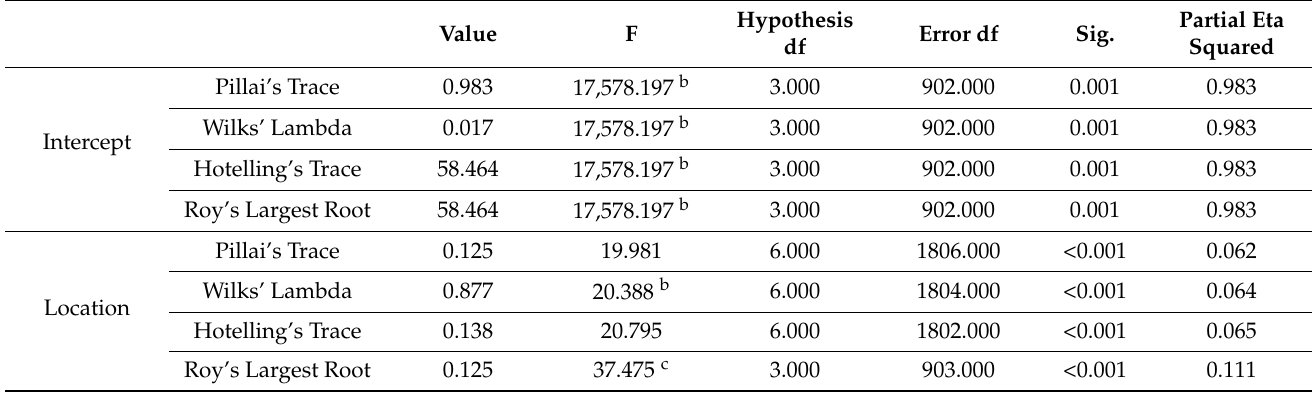
Table 8. Multivariate tests a .